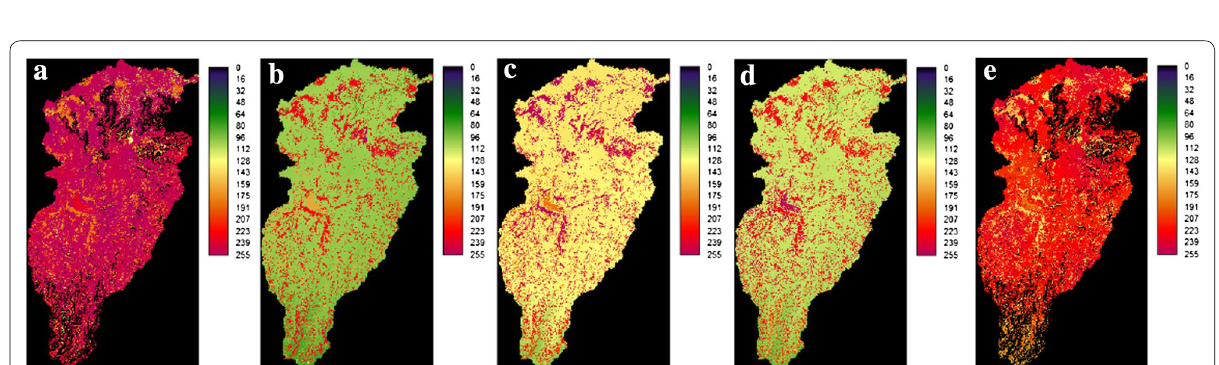
Fig. 2 Suitability map of cultivated land ( a ), forest ( b ), shrubland ( c ), grassland ( d ) and built-up area ( e ) in the Andassa